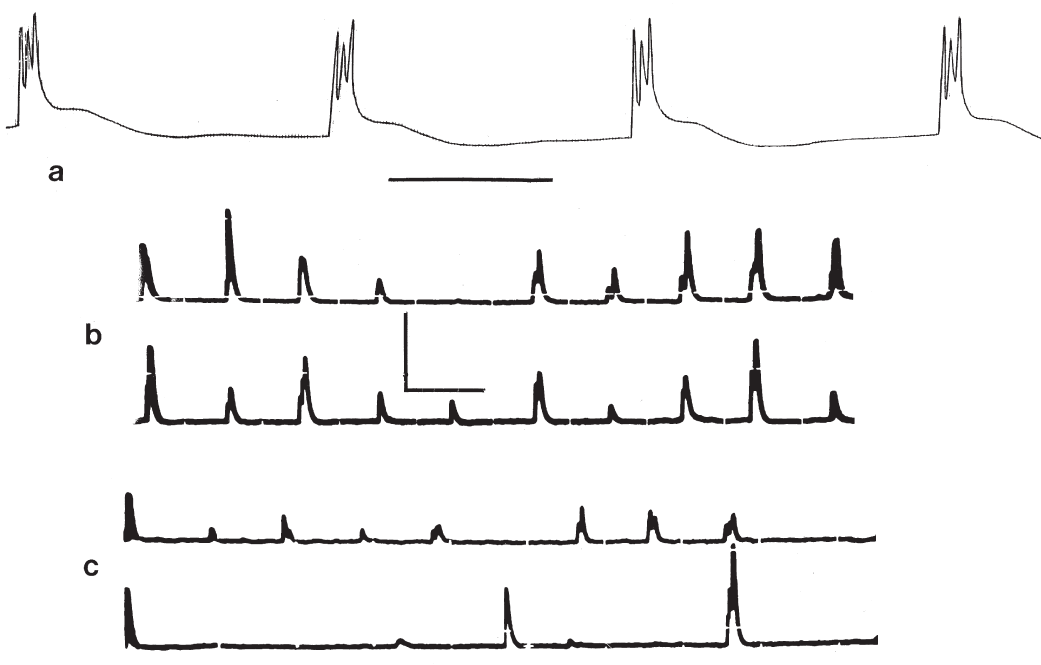
F IG . 5. – a, Ihlea punctata . Intracellular record of rhythmic activity showing similarity of successive potential bursts and absence of inter- mediate or pre-potentials. Scale bar: 1s; b and c, in each, simultaneous intracellular records from marginal fibres (upper line) and central fibres (lower line) from 1.2 cm I. punctata blastozooid. Note that in b electrical events in both fibres are largely similar, whereas in c the marginal fibre is more active than the central fibre. Scale bars: 20 mV, 0. 5